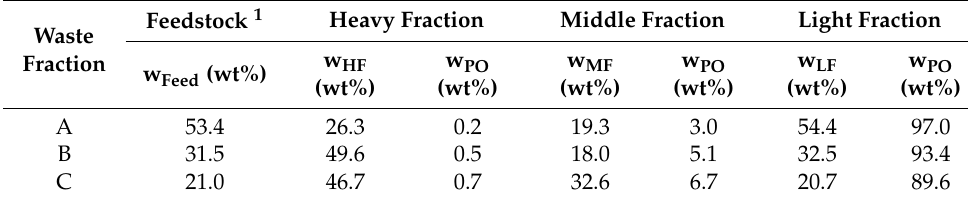
Table 11. Mass fraction of feed (w Feed ), heavy (w HF ), middle (w MF ) and light fraction (w LF ) and corresponding polyolefin fraction(w PO ) of the test series at the lab-scale plant for feedstocks with a high (A), middle (B), and low (C) initial polyolefin share.